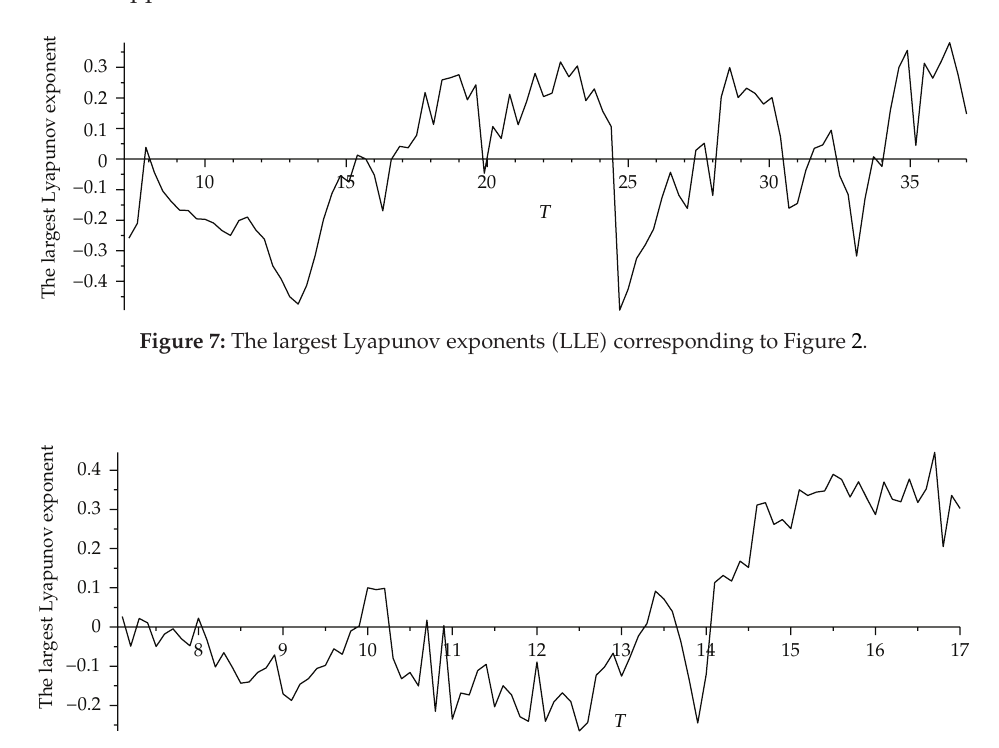
Figure 8: The largest Lyapunov exponents (cid:2) LLE (cid:3) corresponding to Figure